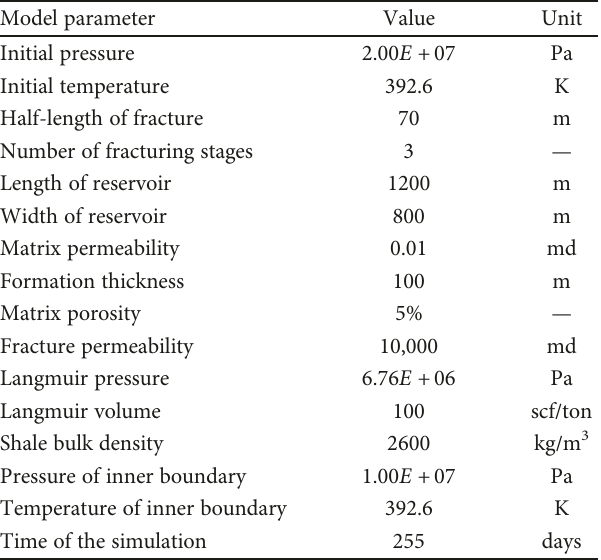
Figure 4: Work fl ow of the proposed thermal-stimulated gas recovery analysis Table 1: Setting of the model parameters in the accuracy validation case.